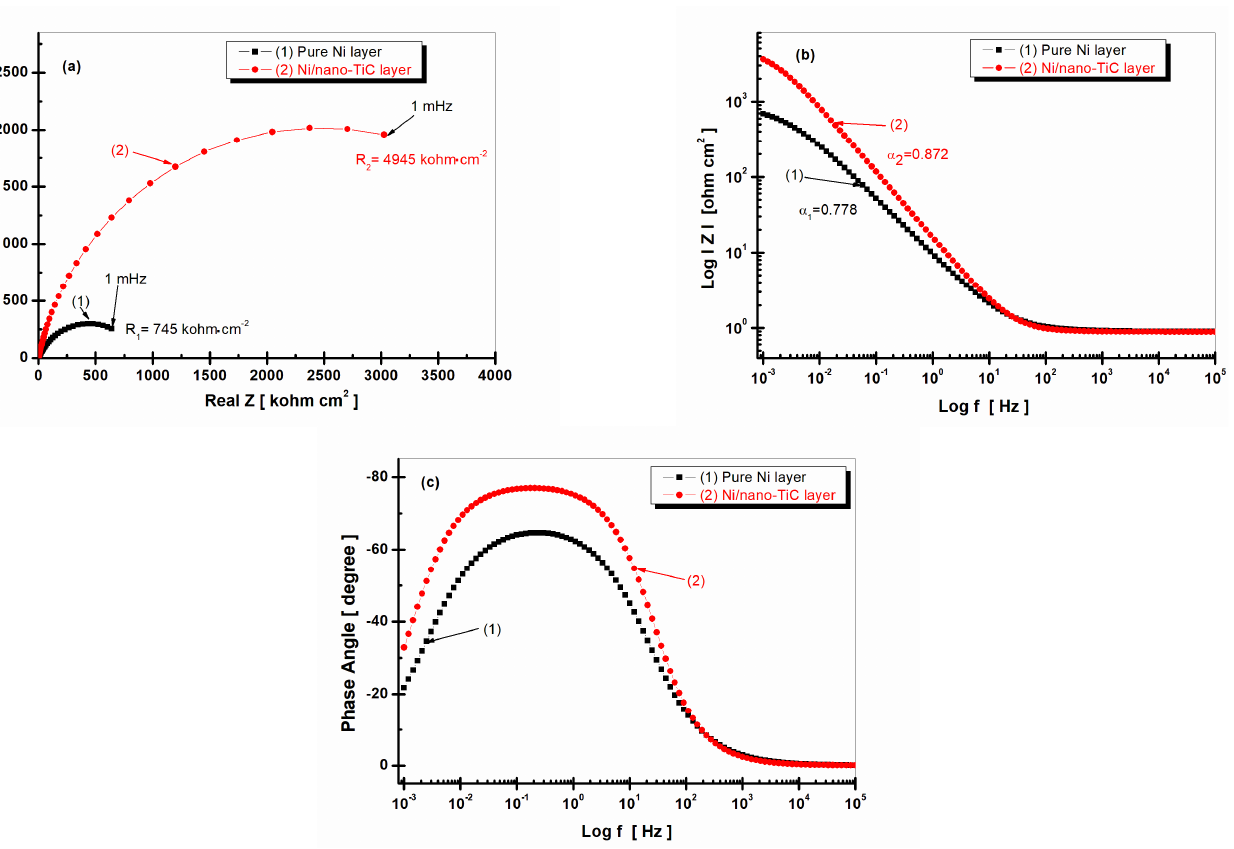
Figure 6. Electrochemical impedance spectroscopy results shown as symbols and the fitted line after 1 h immersion for (1) pure Ni layer; (2) Ni/nano-TiC layer. ( a ) Nyquist representation; ( b ) module Z versus logarithm of frequency; ( c ) phase angle versus logarithm of frequency.